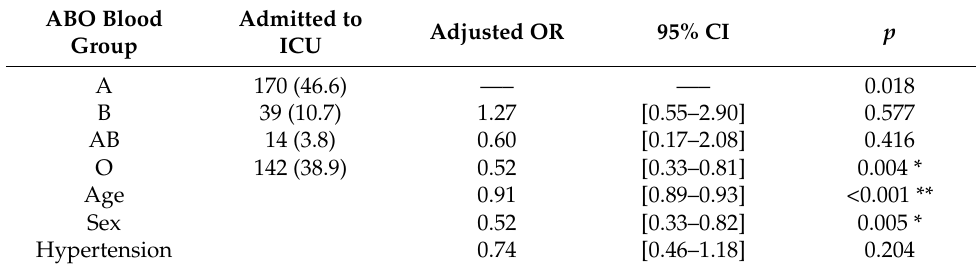
Table 5. Multivariate analysis: ABO blood type versus ICU admission. The referent is blood type A. We express the results of the significance of the variables necessary in the multivariate analysis, diagnoses of hypertension, diabetes, or obesity, and previous cardiovascular, obstructive lung